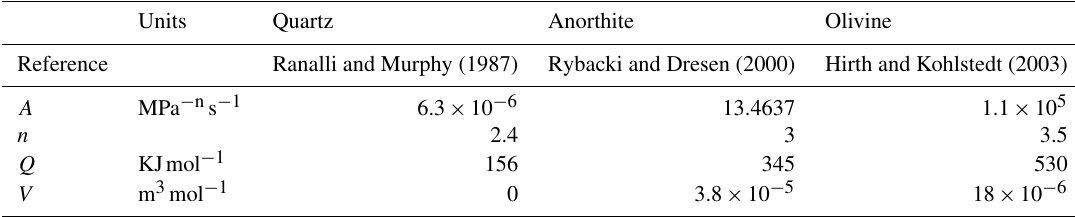
Table 1. Parameters used for the different flow laws in the model.